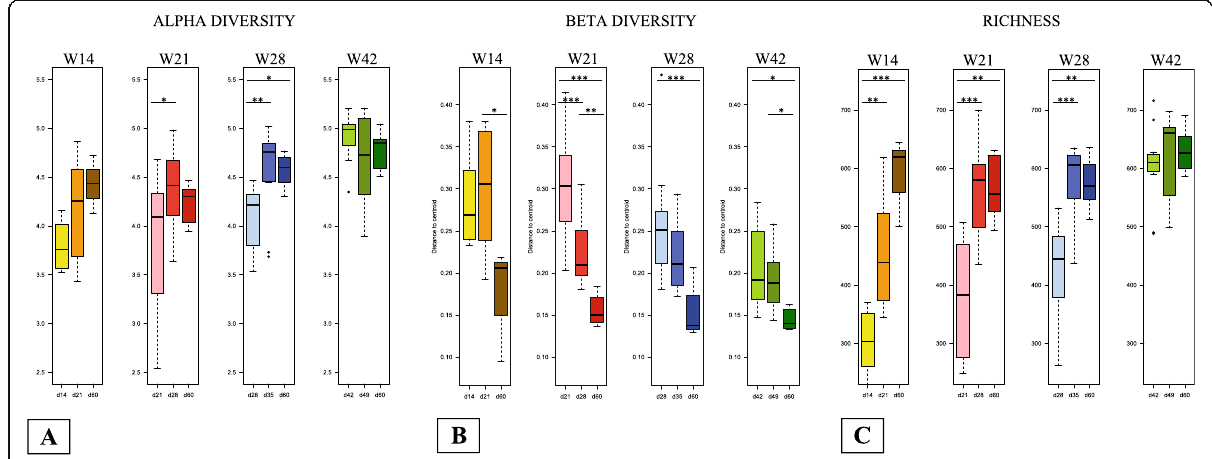
Fig. 3 Boxplots of alpha diversity ( a ), beta diversity ( b ), and richness ( c ) for each sampling point for piglets weaned at 14 days of age (W14), 21 days of age (W21), 28 days of age (W28), and 42 days of age (W42). Any statistical differences are indicated in the figure (* p < 0.05, ** p < 0.01, and *** p <